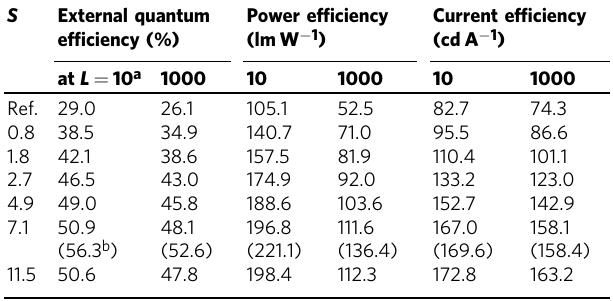
V LEDs, while keeping all the form factor advantages that organic technologies can offer.